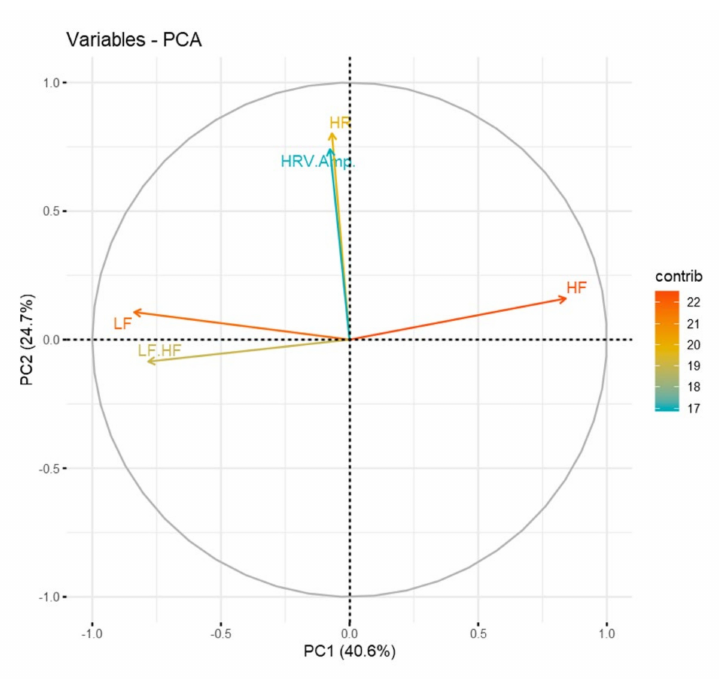
Figure 10. Comparison of parameters based on correlation